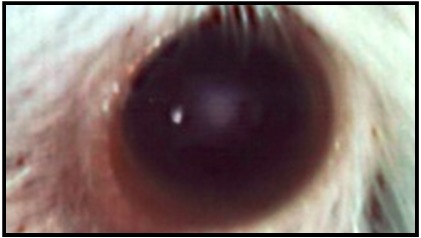
Cataract formation in the PC group 30 days after injection of Na2SeO3